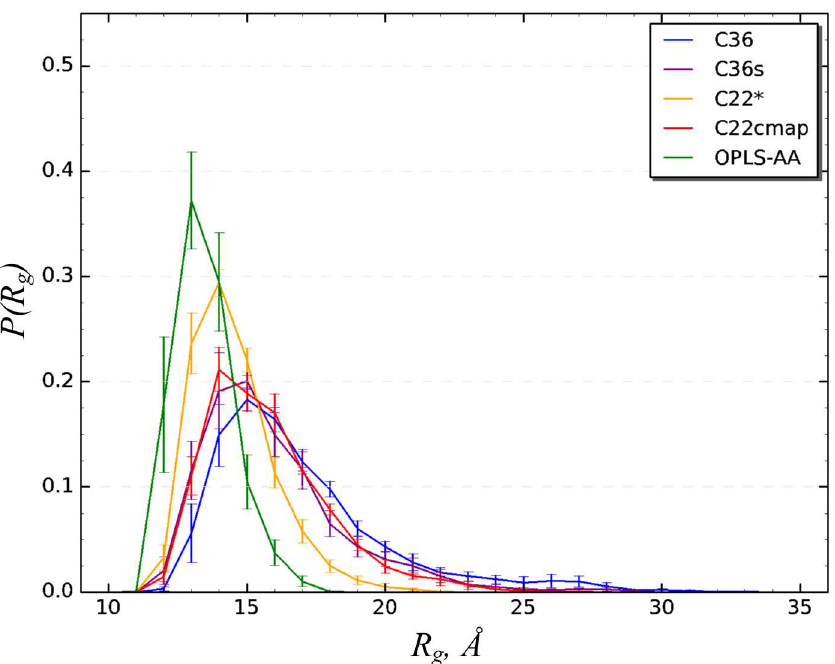
Fig 6. A β radius of gyration in different force fields. Probabilitydistributions, P ( R g ), for the radius of gyration R g of A β 10-40peptidecomputed for five force fields. Vertical bars represent samplingerrors. The plots show that, in contrast to C36, C36s, and C22cmap force fields, C22 * and OPLS-AA predict collapsed